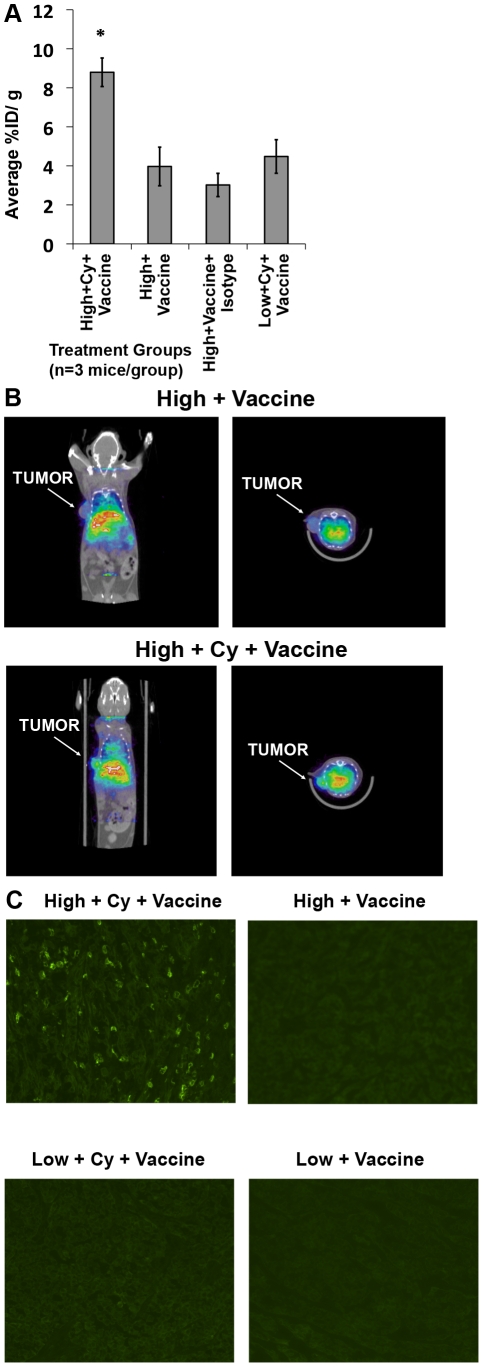
Confirmation of increased high avidity T cell tumor trafficking by in vivo imaging.(A) Neu-N mice were tumor challenged and treated as in the Methods. One day after T cell adoptive transfer mice were treated with In-111 labeled anti-Thy1.2, the tumors isolated and the radiation content analyzed as described in Methods. Isotype = Isotype control treatment group. Tumor radioactivity concentration was reported as the average % injection dose/g of tumor (n = 3mice/group). (B) neu-N mice treated as in 7A, and underwent SPECT/CT imaging. Coronal (left panel) and transverse (right panel) cross-sections through the tumor are shown for each treatment. (C) Tumors were collected on day 5 after adoptive transfer and immunofluorescence stained for Thy 1.2. * = p<0.05. High/low = High or low avidity T cell transfer, respectively. Cy = Cyclophosphamide treatment. Vaccine = 3T3neuGM vaccine. Mock = 3T3GM Control Vaccine. These experiments were repeated 2–3 times with similar results.